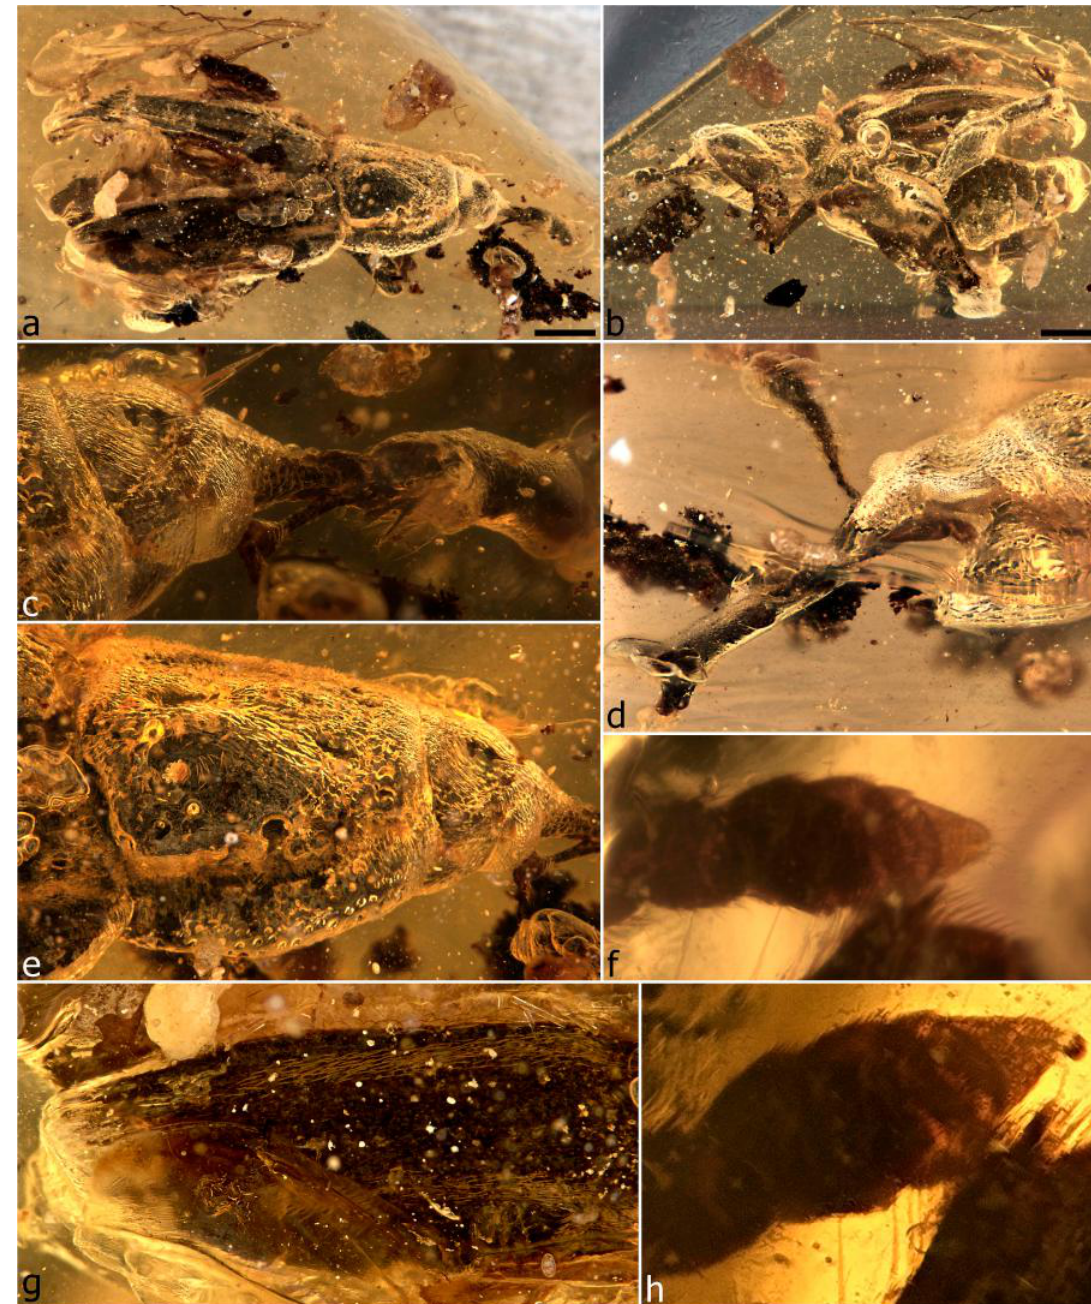
Figure 35. Petalotarsus oxycorynoides sp. n., holotype. Habitus, dorsal ( a ); habitus, left ventrolateral ( b ); head, right dorsolateral ( c ); head, left dorsolateral ( d ); prothorax, dorsal ( e ); antennal club ( f ); right elytron showing setal stripes, dorsal ( g ); antennal club enlarged ( h ). Scale bars: 1.0 mm (a,b).